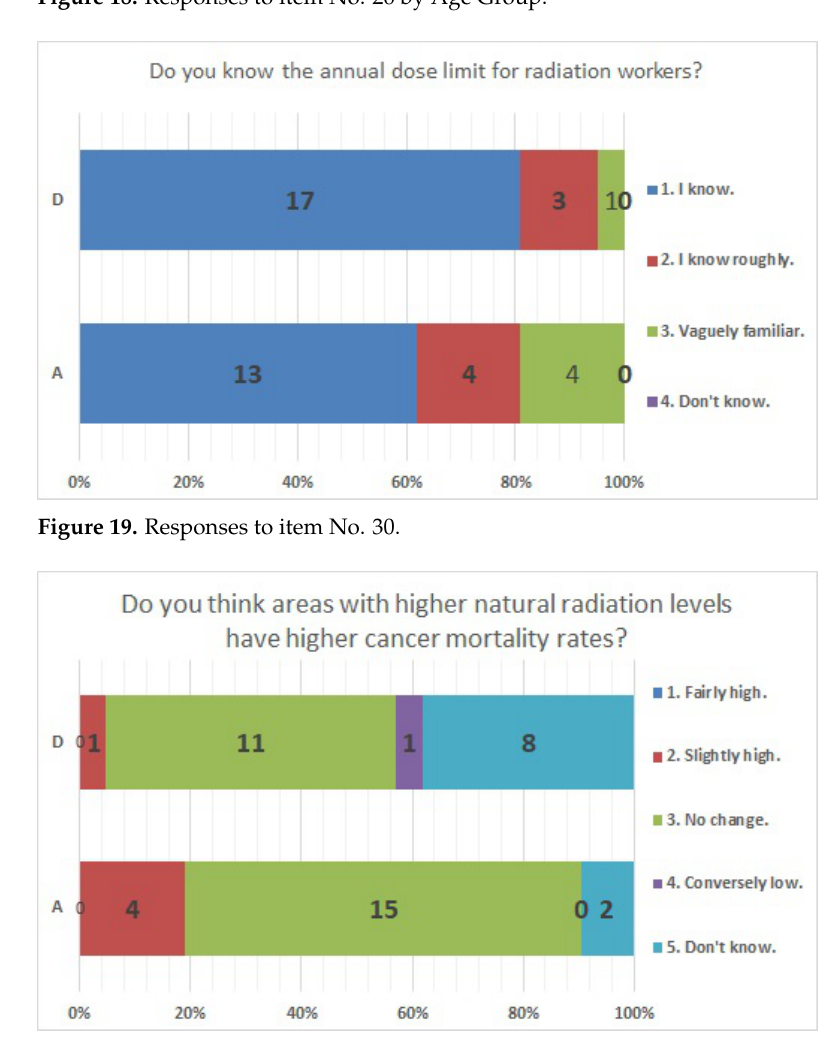
Figure 20. Responses to item No.